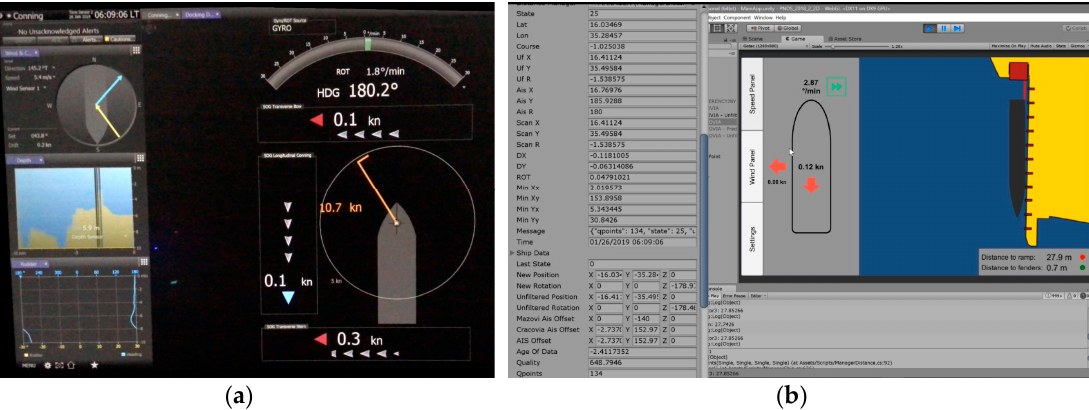
Figure 13. Comparison of speed and tendency of the Cracovia ferry during berth approaching: data available through ship’s conning station ( a ), and PNDS ( b ).